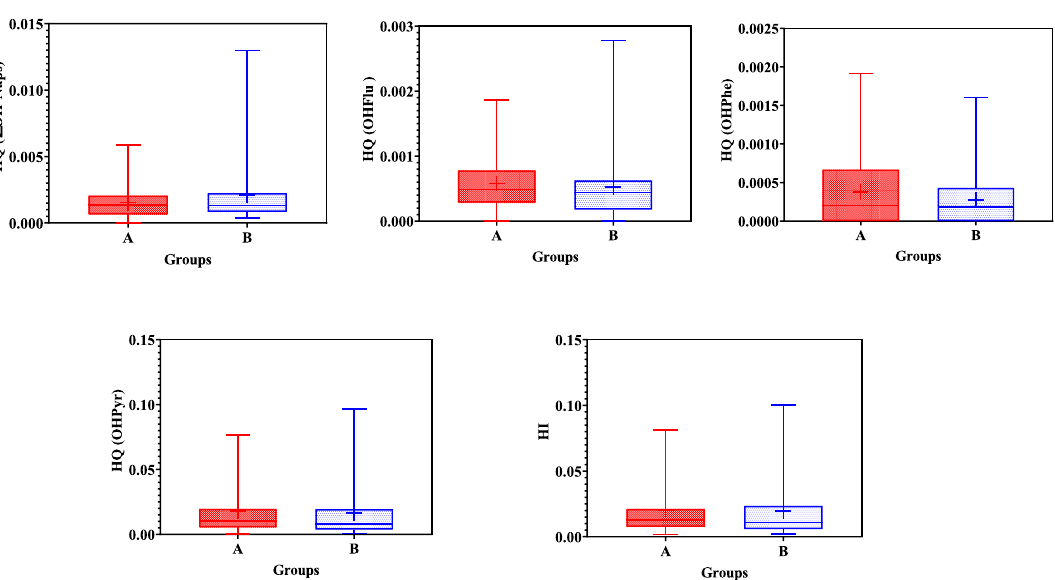
Figure 3. HQs (OHNaps, 2-OHFlu, 9-OHPhe, and 1-OHP) and HIs for ( A ) people living near restaurants and ( B ) control group